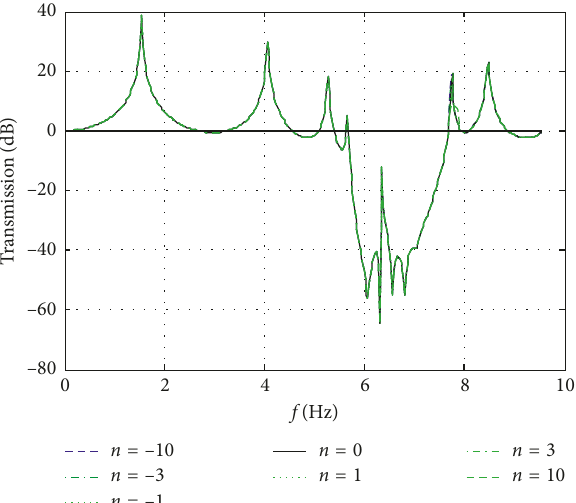
Figure 5: Transmission characteristics with different n ( n